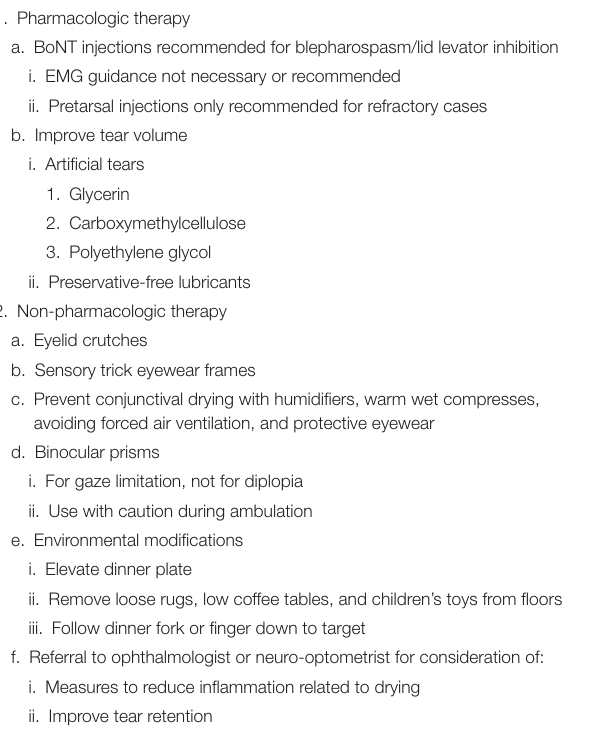
TABLE 4 | Management of eyelid and visual dysfunction in